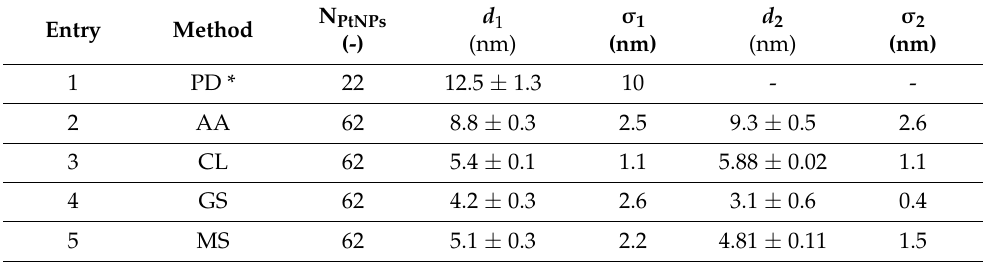
Table 3. Mean particle size ( d ) and deviation ( σ ) obtained from raw data (index: 1) and gauss fit (index: 2).